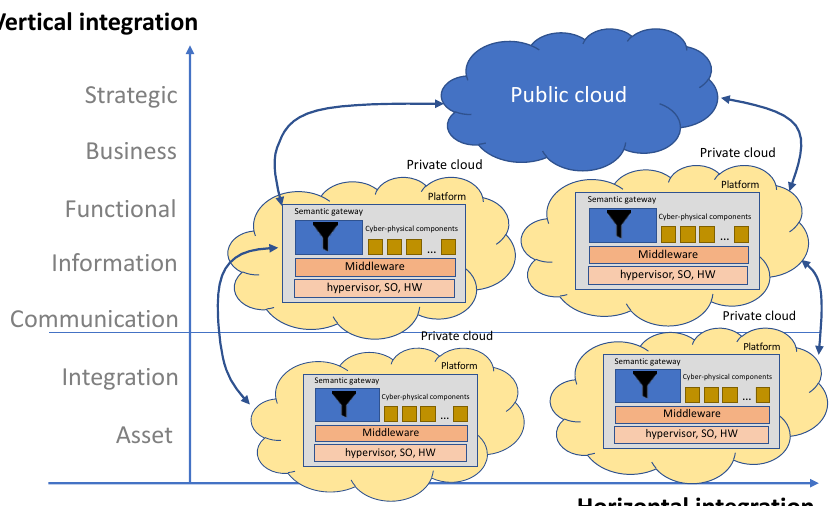
Figure 9. Horizontal and vertical components integration.